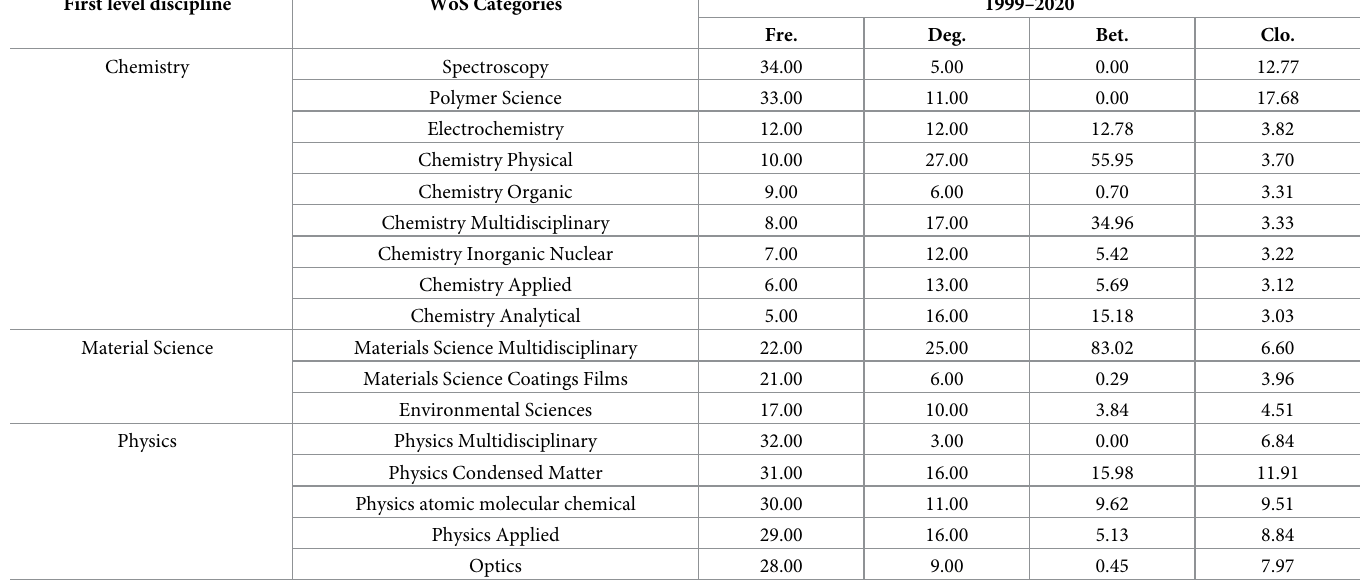
Table 3. The centrality of the main discipline in the period of